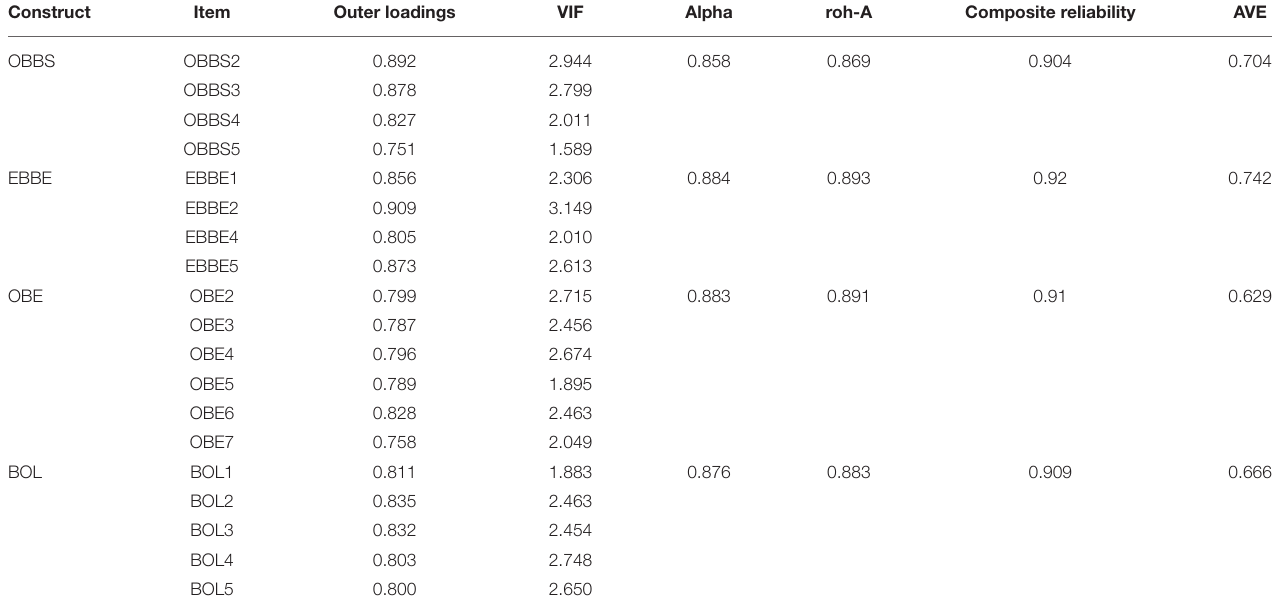
TABLE 2 | Reliability and validity of the study